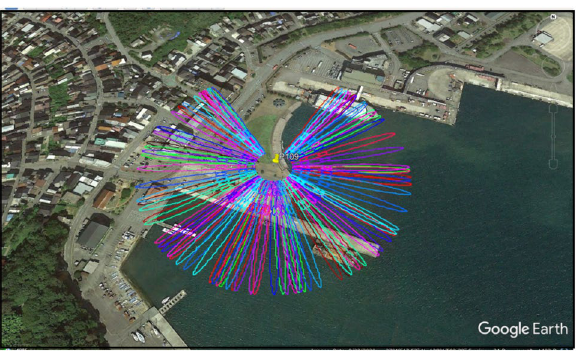
Figure 2. Screenshots of first Fresnel zones for the P109 site with elevation angles of 5° to 25° and azimuth range 30° to 330° projected on a Google Earth map.